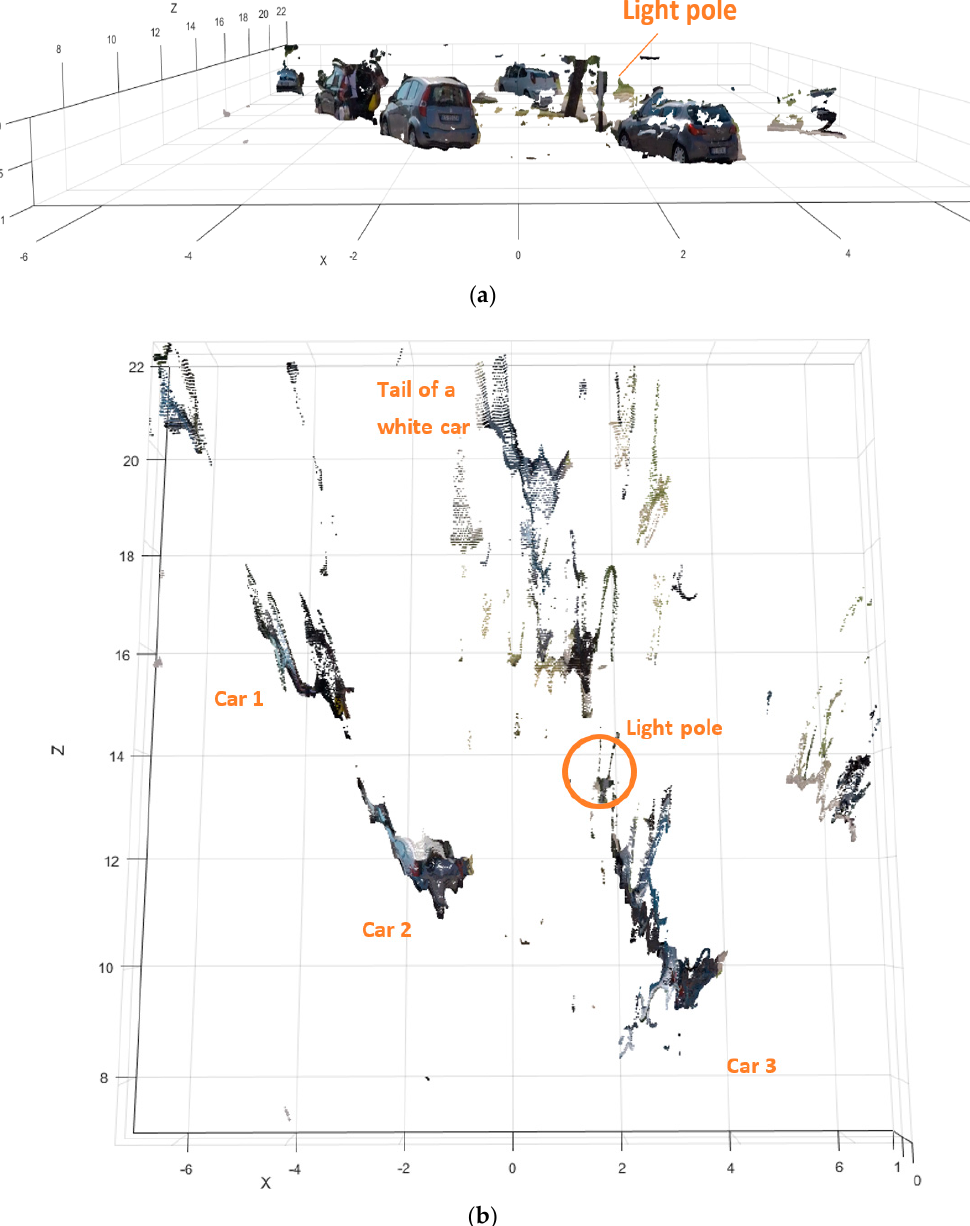
Figure 11. Cleaned measurements of the corresponding to the turning maneuver. ( a ) The 3D point cloud inclined 13° to compensate the leaning of the scooter; ( b ) Top view of the measures. cloud inclined 13 ◦ to compensate the leaning of the scooter; ( b ) Top view of the Note: the 3D point clouds presented until now contain all the raw data measurements retrieved from the stereo cameras. However, certain details are difficult to assess the 3D measurements.